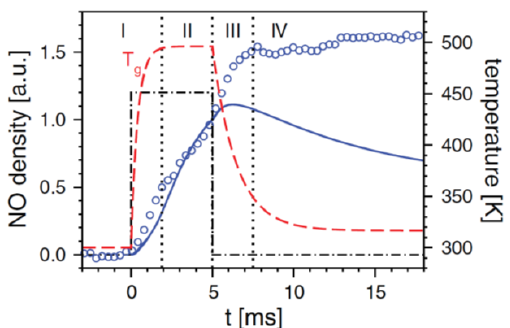
Figure 13. ( a ) Temporal evolution of selected atomic species and ( b ) of electronically excited nitrogen molecules for the case of a current of 150 mA [64], © IOP Publishing. Reproduced with permission. All rights reserved.